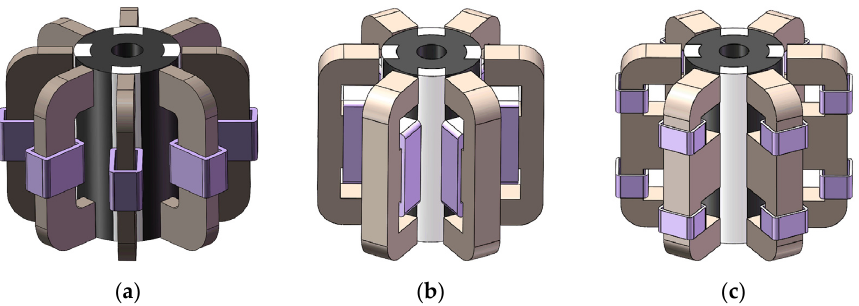
Figure 19. Segmental stator SRMs with radial segmental rotors. ( a ) 8/4 segmental stator SRM; ( b ) and ( c ) are 6/4 segmental stator SRMs with single coils and double coils, respectively. Notes: the white area represents the segmental rotors, whereas the black area is the non-magnetic isolator.